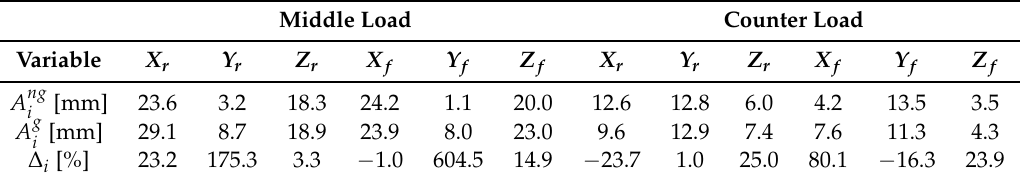
Table 1. Experimental amplitudes and percent difference with/without gasket. Middle Load Counter Load